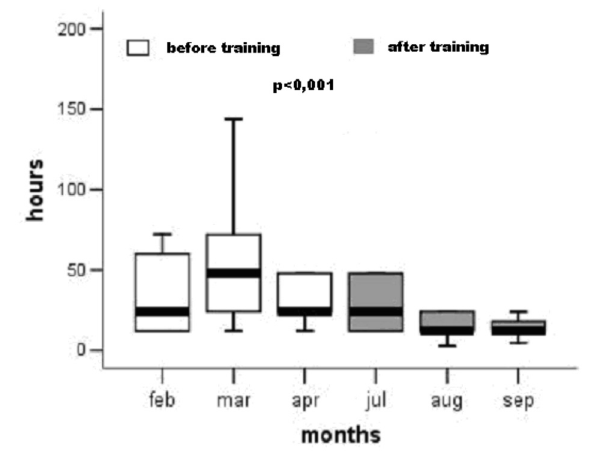
Figure 4 - Medians and interquartile intervals of time (in hours) to admission to the ICU during study, before and after training. Friedman